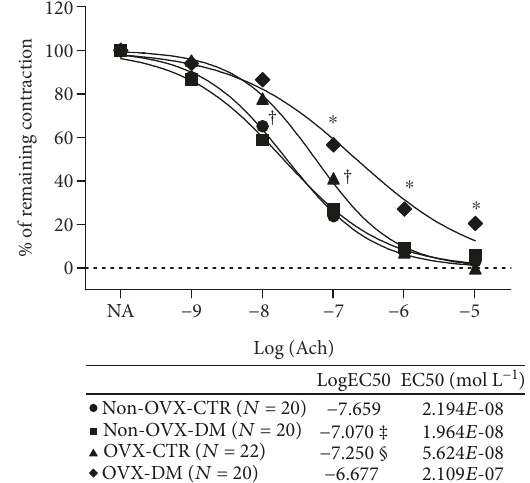
Figure 1: ACh-induced relaxation (AChIR) of isolated rat aorta rings in non-OVX-CTR and non-OVX-DM rats and OVX-CTR and OVX-DM rats. AChIR was signi fi cantly impaired in the OVX-DM group when compared to the non-OVX-DM group of rats at 10 -7 -10 -5 M ACh concentration. Both non-OVX-DM and OVX-DM rats exhibited lower sensitivity to ACh compared to their corresponding controls (table within the panel). AChIR was (at 10 -7 -10 -5 M ACh concentration) and OVX-DM compared to Both OVX-CTR and OVX-DM rats exhibited lower sensitivity to ACh compared to non-OVX groups, respectively (table within the panel). LogEC50 values (shown in the corresponding table)